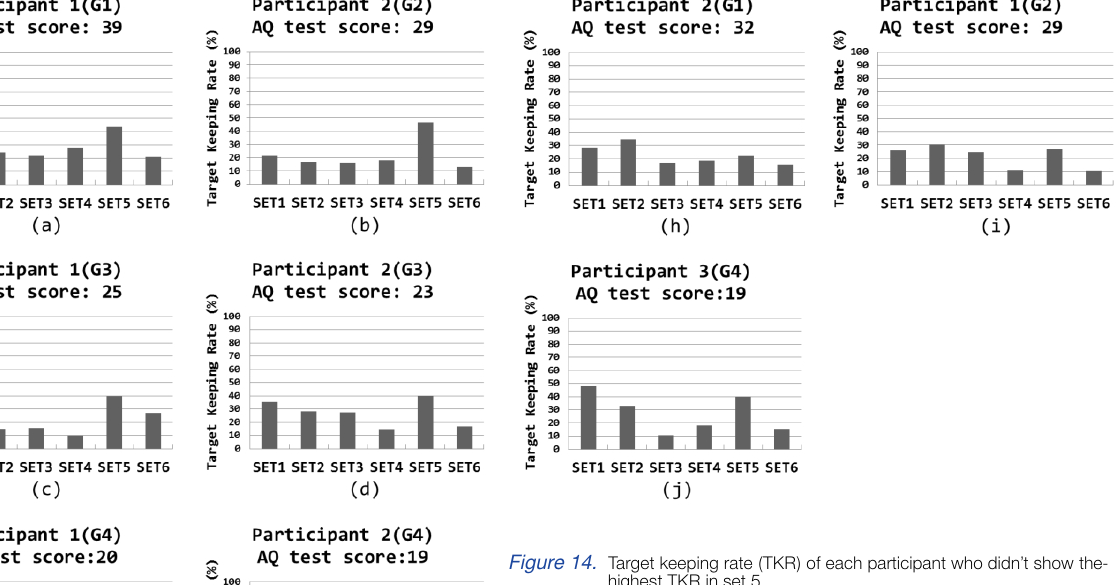
Figure 14. Target keeping rate (TKR) of each participant who didn’t show the- highest TKR in set 5.